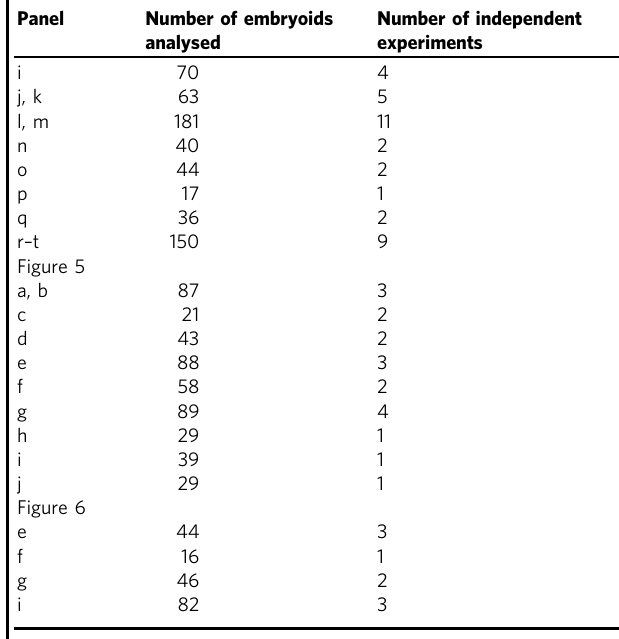
Number of independent experiments